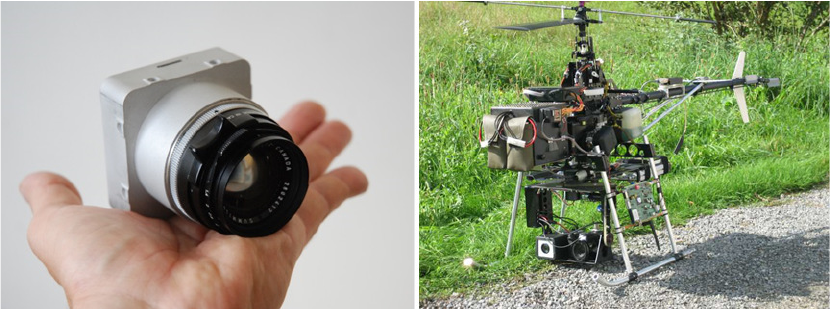
Figure 1. Institut national de l’information géographique (IGN) camera with the Copter 1B UAV developed by Wikhydro.